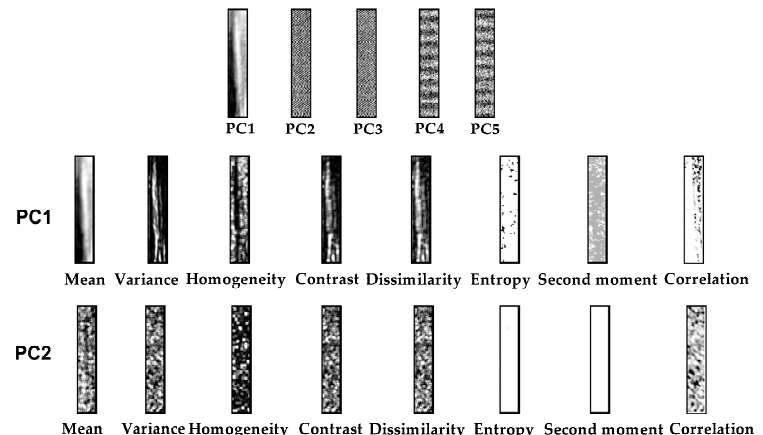
Figure 5. Texture feature images and PC images of a rice sample. Table 3. Detection accuracy of infestation degrees by the BPNN model based on the GLCM features. Model